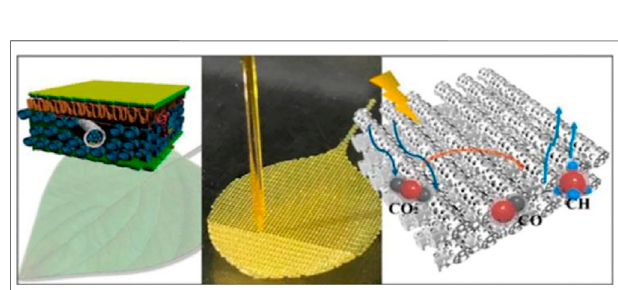
FIGURE11| 3Dprintingofarti fi cialleafwithtunablehierarchical porosity for CO 2 photoreduction (Chen et al.,